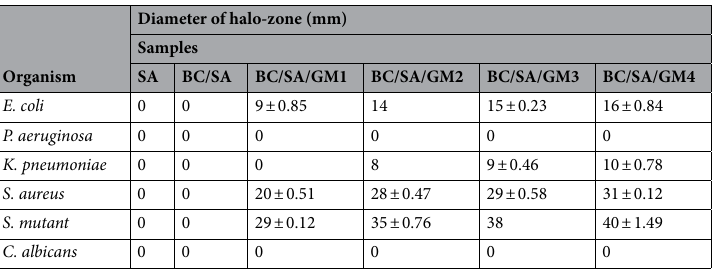
Table 5. The antimicrobial activity of the prepared BC/SA/GM composite at four concentrations against six pathogenic